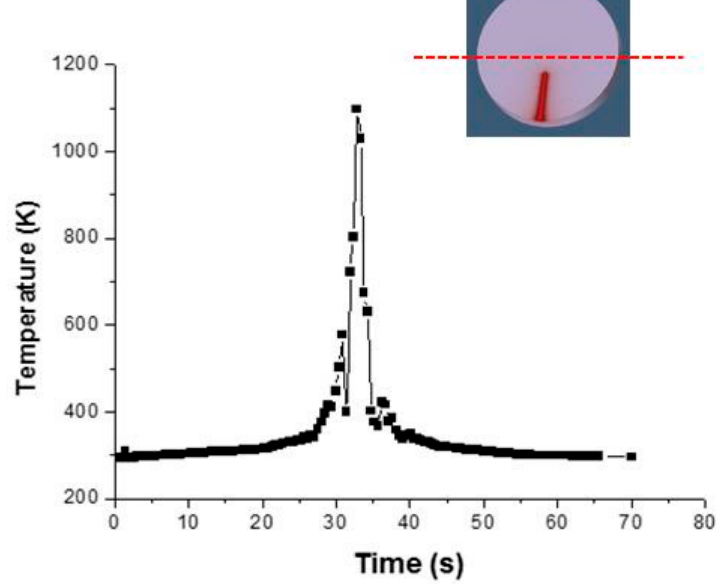
Figure 18. Thermal cycle measured in di ff erent points along a diameter perpendicular to the direction of the heat treatment.